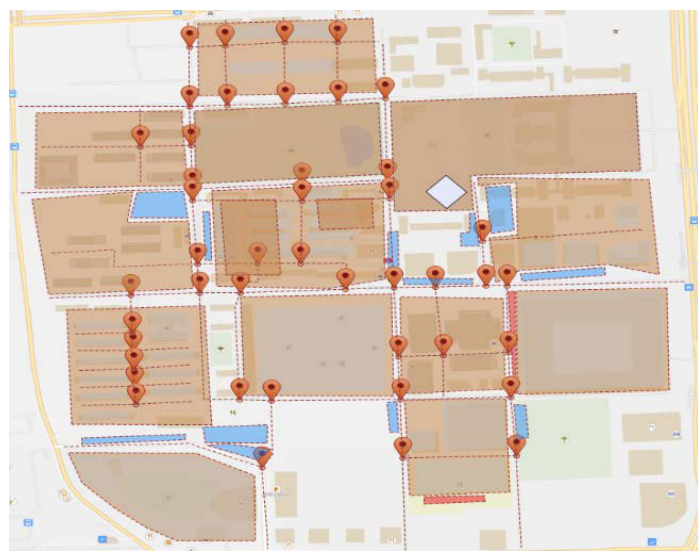
Figure 8. Interface of the campus environment simulation. Table 2. The parameters of the simulation model.